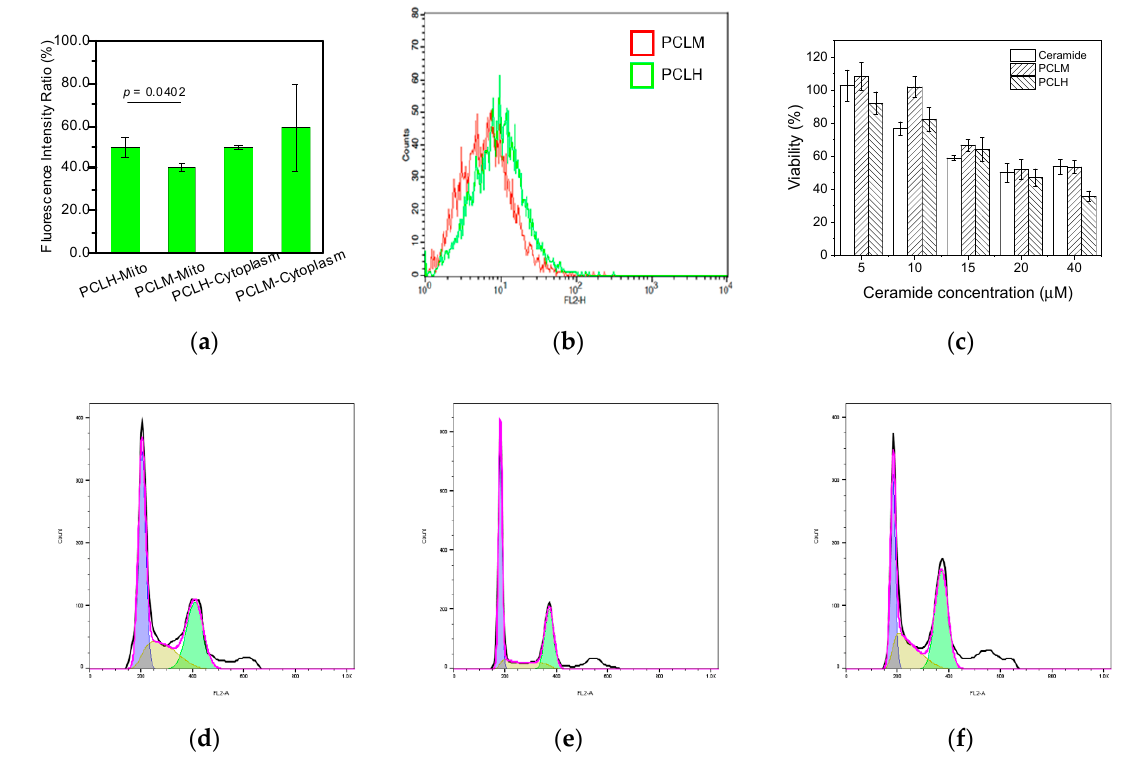
Figure 9. Function of polymer–liposome complexes on MCF-7 cells. ( a ) The FITC fluorescent intensity ratio of mitochondria and cytoplasm by ELISA reader determination after treating with polymer–liposome complexes for 24 h. ( b ) ROS generation of MCF-7 determined by flow cytometry after the treatment of polymer–liposome complexes for 24 h. ( c ) Cytotoxicity of MCF-7 using MTT assay after treatment with free ceramide and polymer–liposome complexes for 24 h. Cell cycle arrest of MCF-7 through flow cytometry analysis after treatment with ( d ) ceramide, ( e ) PCLM, and ( f ) PCLH for 24 h. The violet, yellow, and green regions represent the G0/G1, S, and G2/M phases, respectively ( n = 3, displaying the measurements and statistical p value of one data point).